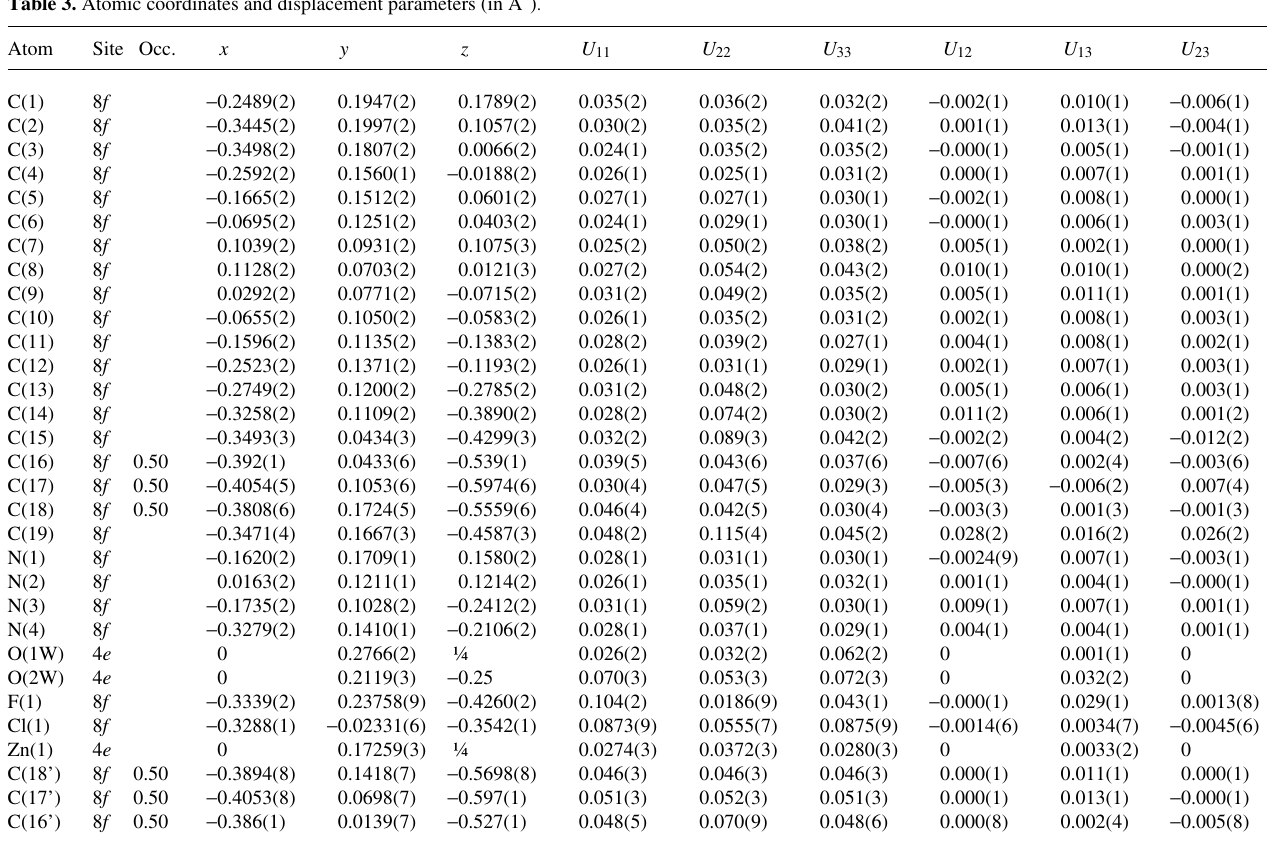
Table 3. Atomic coordinates and displacement parameters (in Å 2 )